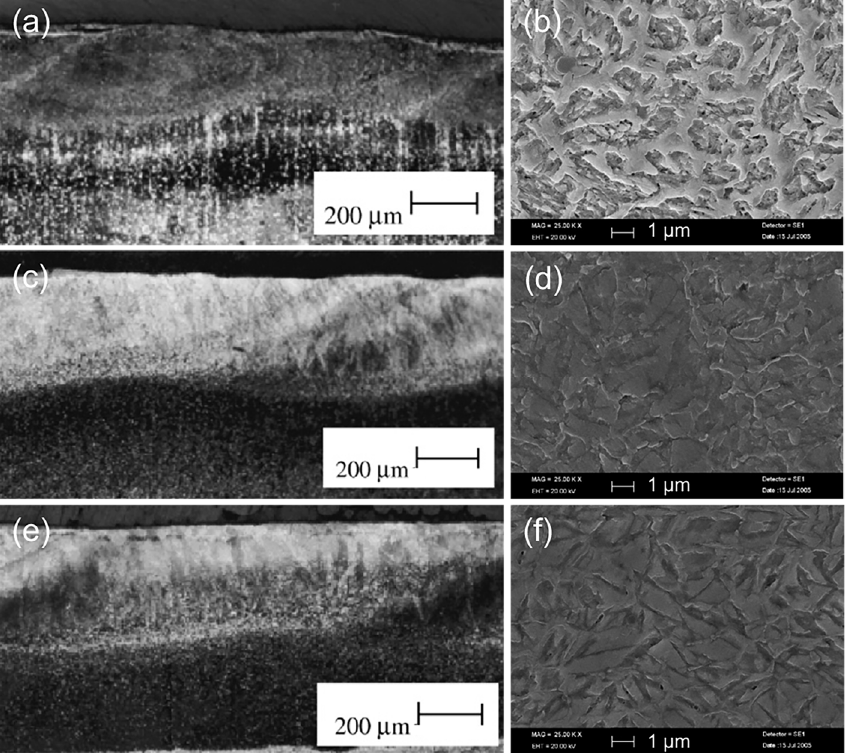
Figure 7. Optical images of cross-sectional appearance and SEM images of the melting zone (MZ)of the laser-melted specimens ( a , b ) LSM-M2; ( c , d ) LSM-ASP23; ( e , f ) LSM-ASP30 [35].